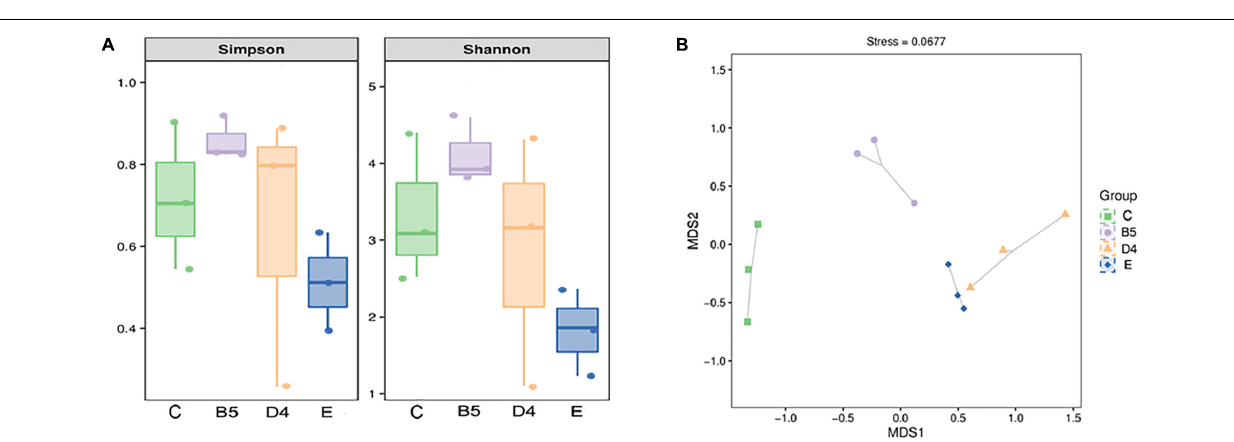
FIGURE 4 | Simpson and Shannon indices (A) and Bray-Curtis (B) based on non-metric multidimensional scaling in trial 3